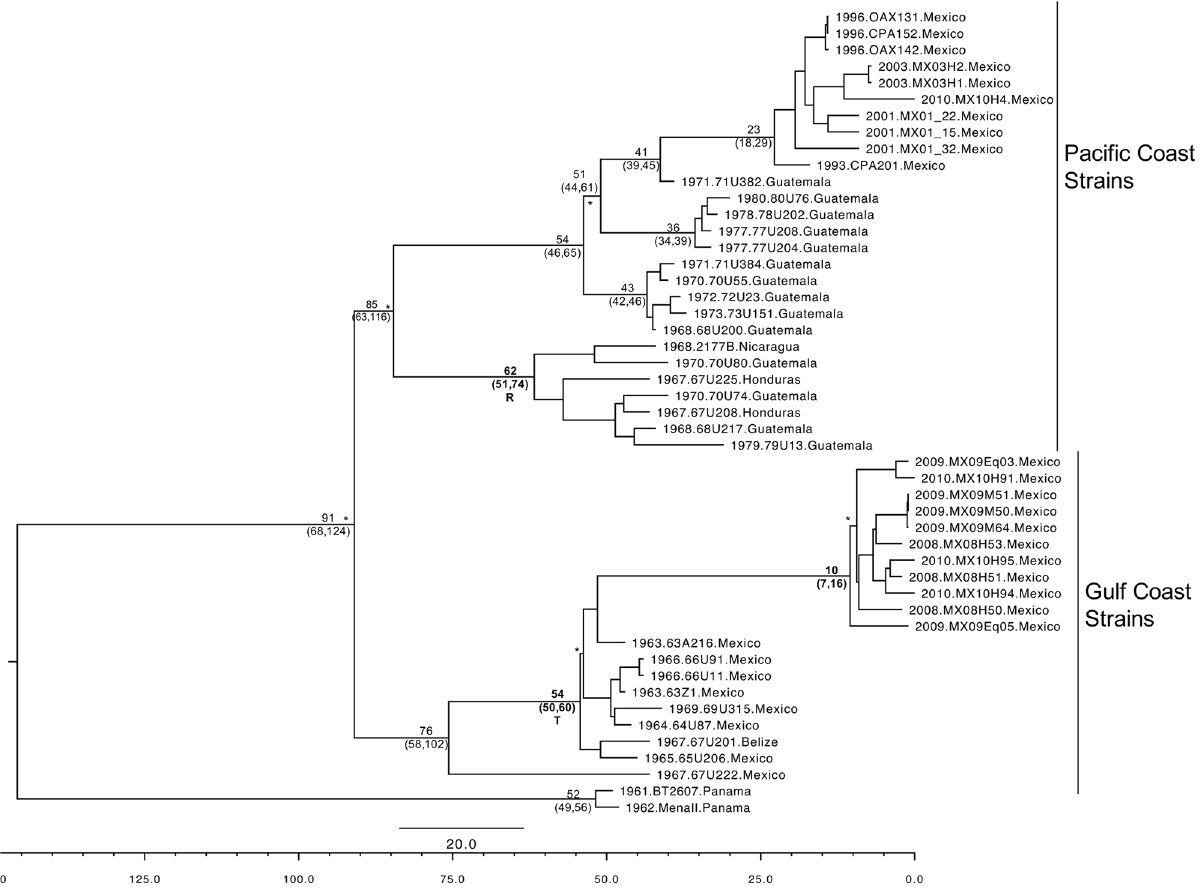
Fig 4. The genetic relationships of the IE subtype of the VEEV complex. MCC tree as determined by coalescentanalysisfor the IE strains. All branches had posterior probabilities of > 0.97 except for the branchesmarked with a * , which did not have significantsupport. Time to most recent common ancestor (tMRCA) as determined by the MCC tree were added to major brancheswith the HPD in brackets. If the clades were supported by BSREL the tMRCA and HPD were emboldened.